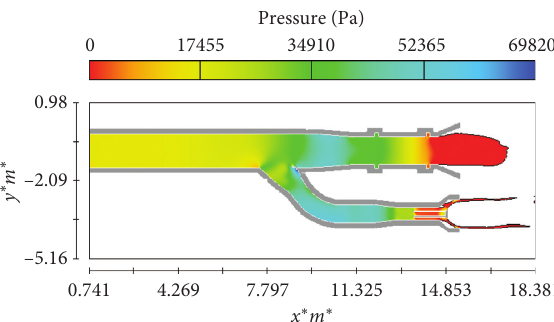
Figure 19: The pressure amount in the channel area leading to the gate and the branch in the state of 100% opening (100% valve opening).